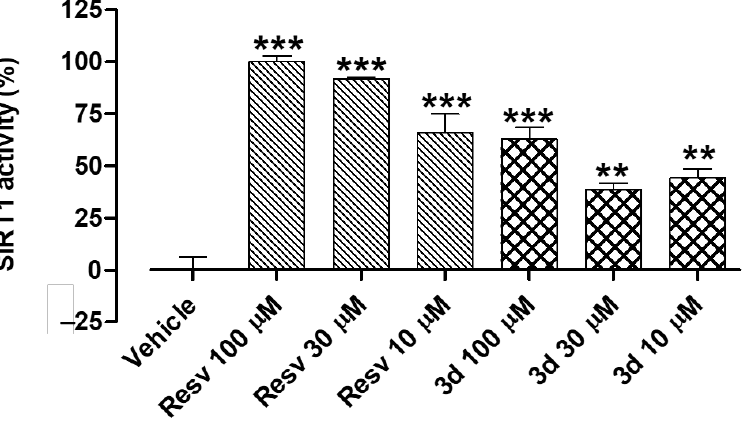
Figure 6. Effects of increasing concentrations of resveratrol and the synthetic derivative 3d (10, 30, and 100 µM) on the isolated SIRT1 enzyme. SIRT1 activity is expressed as % of the effect promoted by the reference compound resveratrol (Resv) 100 µM. Results are shown as mean ± SEM. * indicates significant difference vs. vehicle (** p < 0.01; *** p < 0.001).